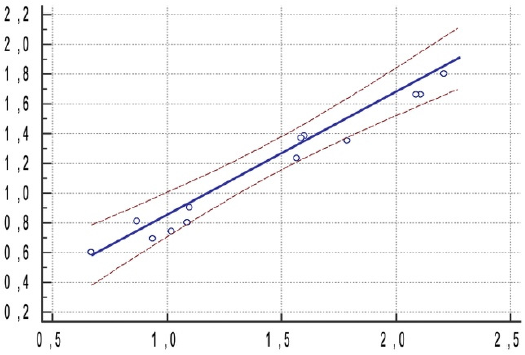
Figure 8. Regression equation (y = 0.03080 + 0.8254x, blue line) and confidence intervals (brown lines) assessing a statistically significant correlation between linear deviation at apex point and linear deviation at shoulder